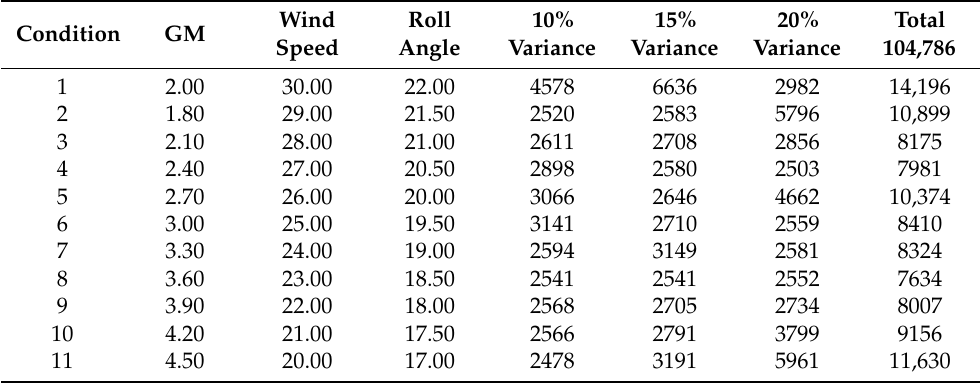
Table 1. Training and test